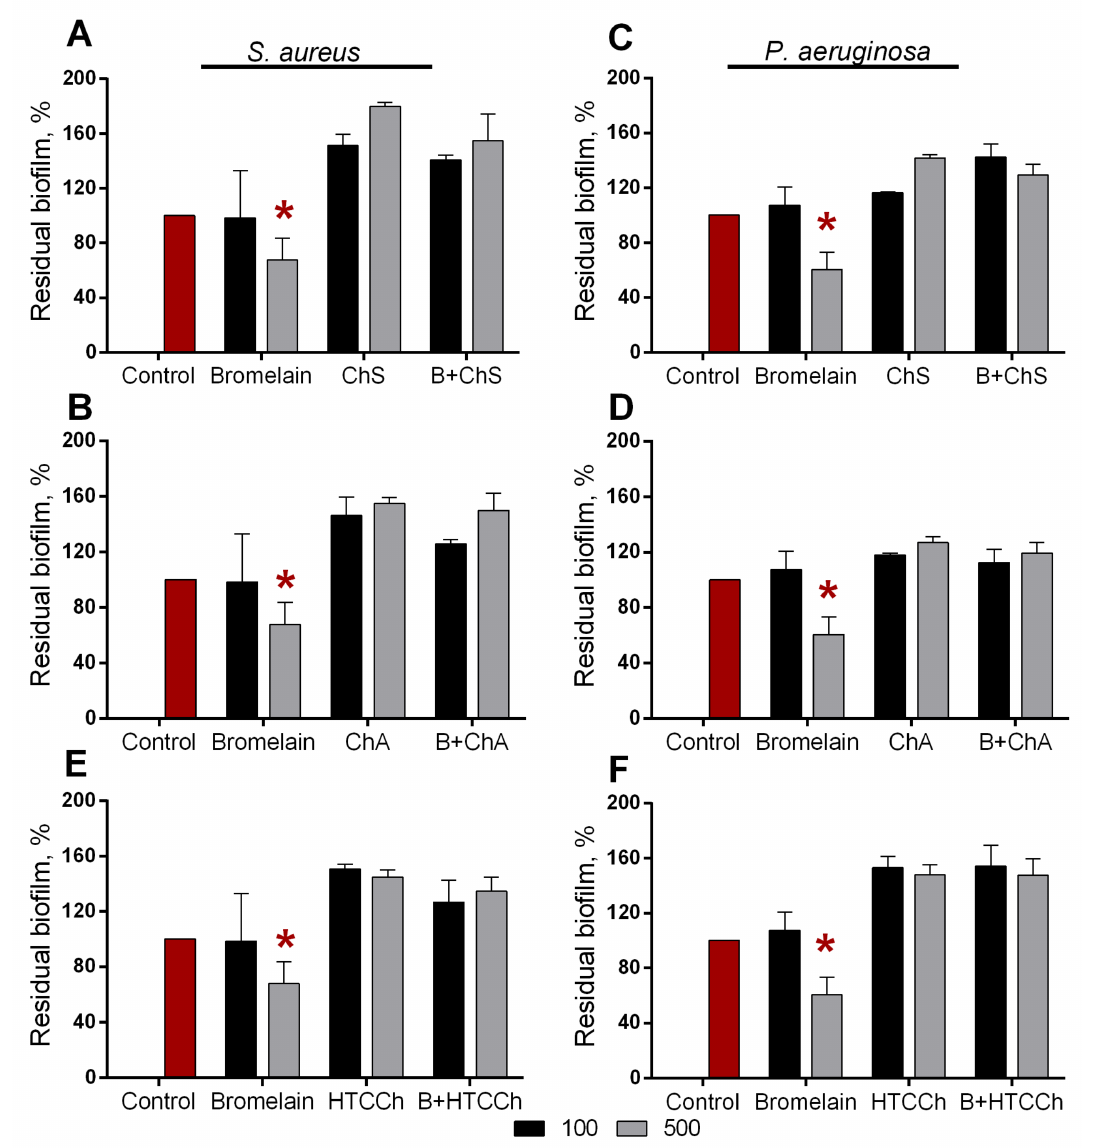
Figure 9. Effect of soluble bromelain and enzyme immobilized on N -(2-hydroxypropyl)-3- trimethylammonium chitosan (HTCCh), chitosan sulfate (ChS), and chitosan acetate (ChA) on on ( A , B , E ) S. aureus and ( C , D , F ) P. aeruginosa biofilms. The 48 h old biofilms were gently washed and treated for 24 h with enzymes at concentrations of 0.1 and 0.5 mg · mL − 1 . The amount of heteroge- neous enzyme corresponded to 0.1 and 0.5 mg · mL − 1 of the soluble enzyme; pure carriers in similar concentrations were taken as a negative control. The residual biofilms were quantified with crystal violet staining. Asterisks (*) denote statistically significant differences between untreated and treated samples ( p < 0.05). Untreated wells were considered to be